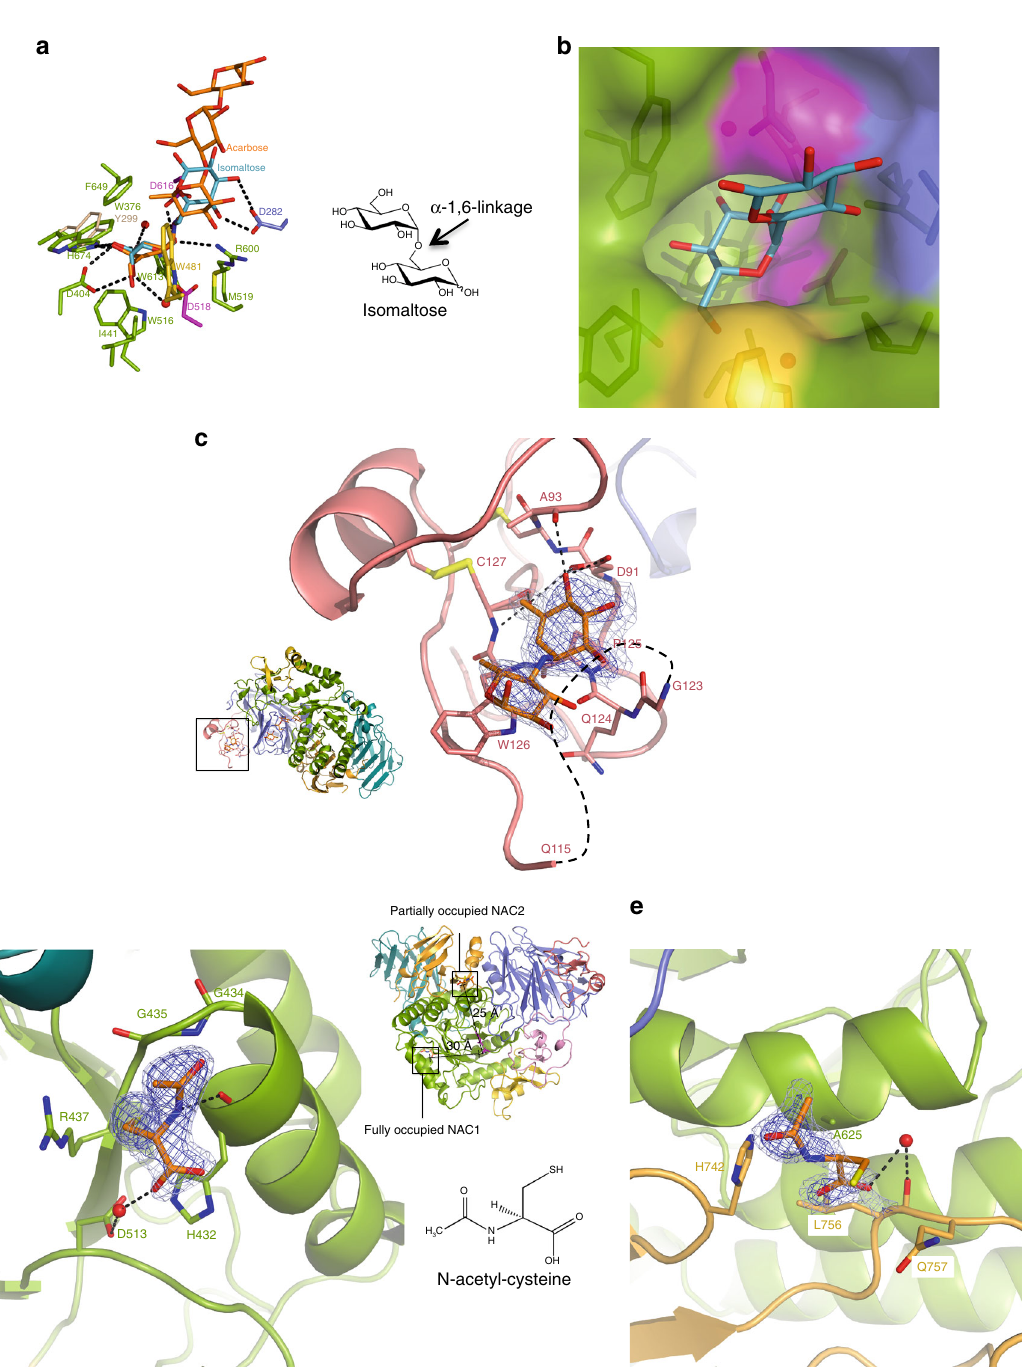
Fig. 4 rhGAA substrate recognition and speci fi city and allosteric chaperone binding sites. a Model of isomaltose (steelblue), derived from an overlap with B. obeum α -glucosidase in complex with isomaltose (PDB ID 3MKK), superposed onto the rhGAA-acarbose complex (rmsd of 1.50 Å for 318 aligned C α positions). b Model of isomaltose bound to rhGAA in surface representation. c The secondary substrate-binding site of rhGAA with unbiased F o – F c difference electron density map calculated before incorporation of acarvosine (orange) into the model and contoured at 2.0 (lightblue) and 3.0 (blue) σ . The surface loop removed by proteolytic treatment is represented by dashed lines. d NAC1 (orange) in the fully occupied binding site. e NAC2 (orange) in the partially occupied binding site. In d and e , unbiased F o – F c difference electron density maps, calculated before incorporation of NAC into the model, are shown in lightblue (2.0 σ ) and blue (3.0 σ